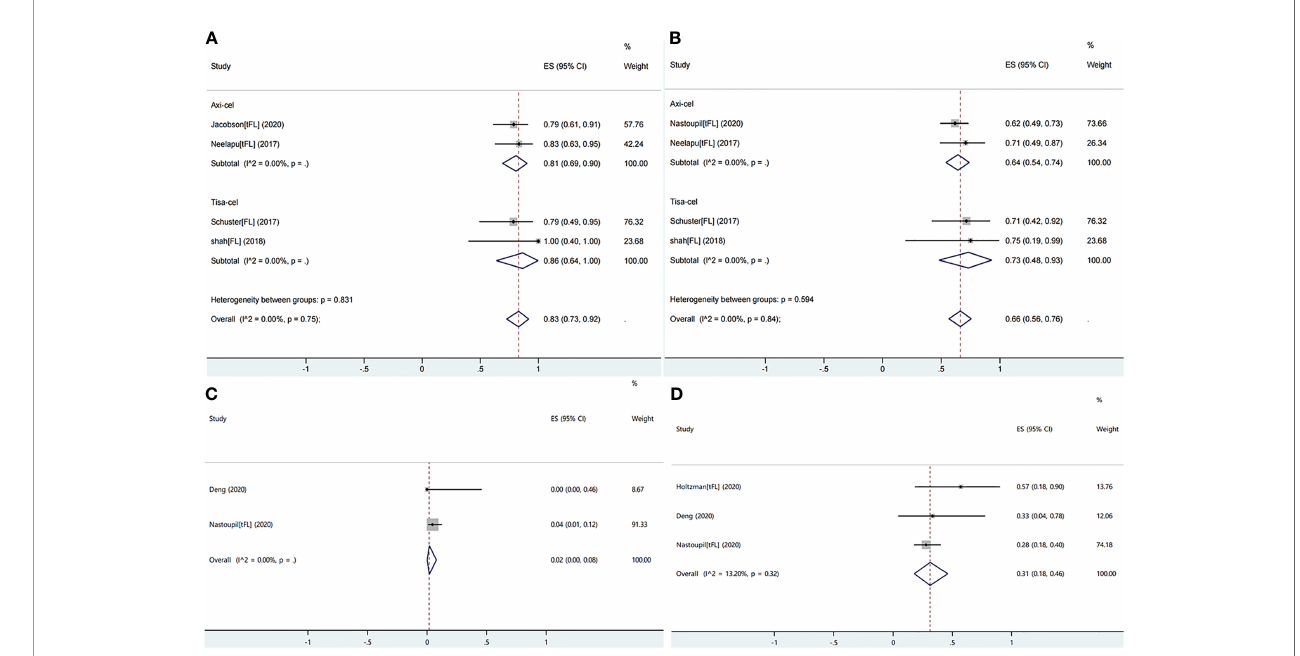
FIGURE 7 | The forest plots of pooled results in patients with follicular lymphoma or transformed follicular lymphoma. (A) The forest plot of overall response rate of each product. (B) The forest plot of complete response rate of each product. (C) The forest plot of severe cytokine release syndrome rate of axi-cel. (D) The forest plot of severe immune effector cell-associated neurotoxicity syndrome rate of